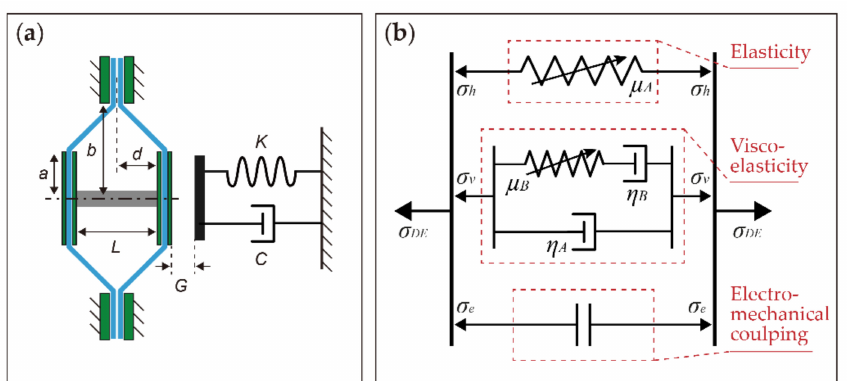
Figure 2. ( a ) Sketch of the resonant-impact DEA system model and ( b ) illustration of the material